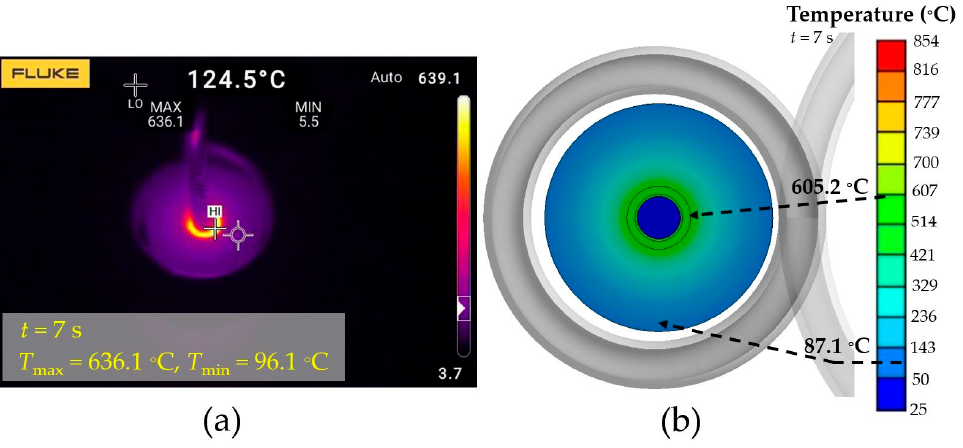
Figure 11. The temperature distribution on the product’s surface from ( a ) the experiment #2 and ( b ) the multiphysics, at 7 s from the start.